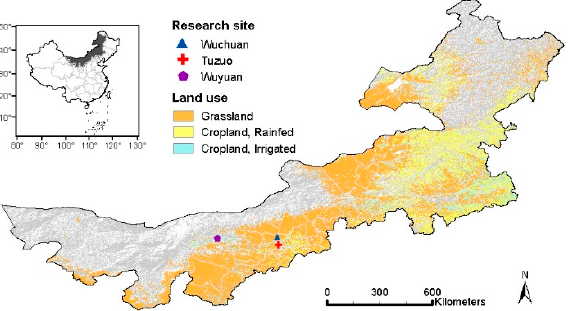
Figure 1. Location of the research sites. Spatial distribution of the grassland and cropland is extracted from ESA CCI 1.3 land cover and upscaled to 1 km grid resolution. The underlying digital terrain is based on NASA’s Shuttle Radar Topography Mission, also upscaled to 1 km